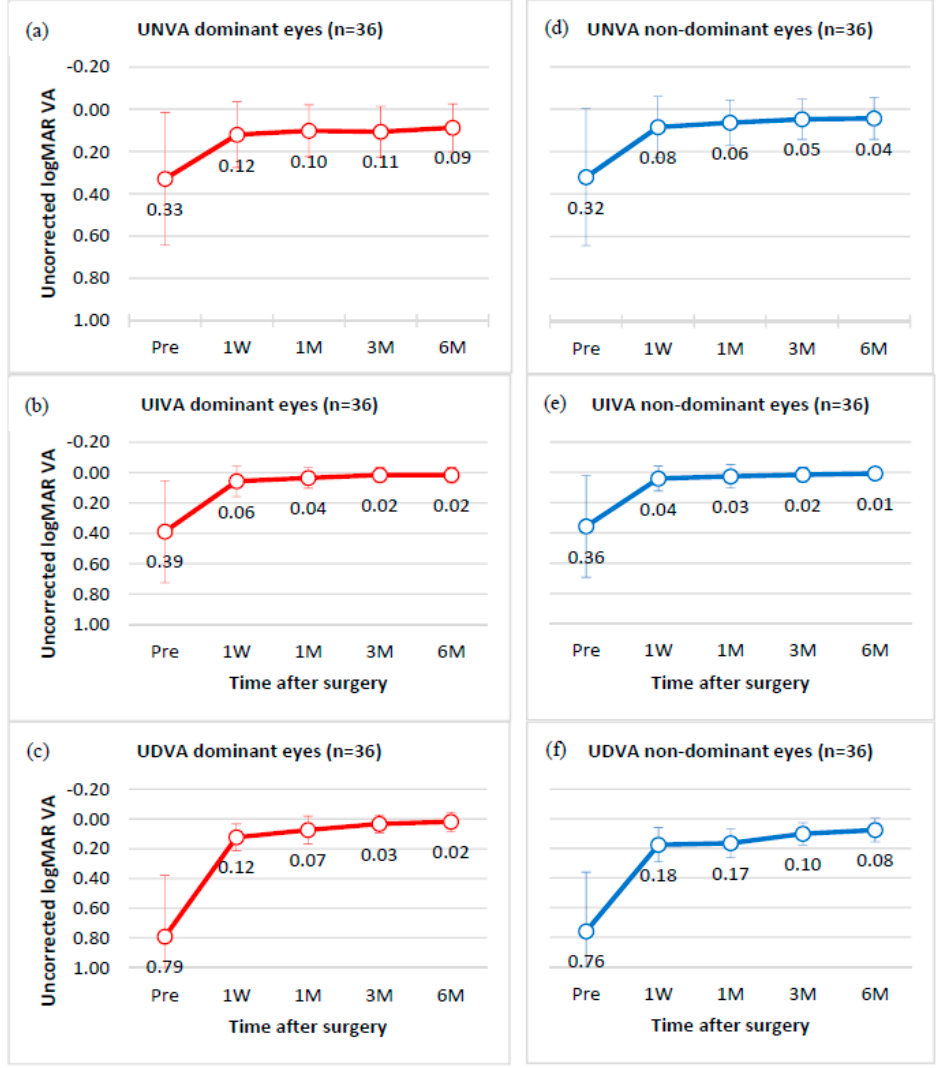
Figure 6. Mean and standard deviation of monocular uncorrected visual acuity for near (UNVA), intermediate (UIVA), and distance vision (UDVA) for 36 dominant ( a – c ) (shown in red), and 36 non-dominant ( d – f ) (shown in blue) eyes. Values are given preoperatively, and at one week (1 W), one month (1 M), three months (3 M), and six months (6 M) postsurgical follow-up.